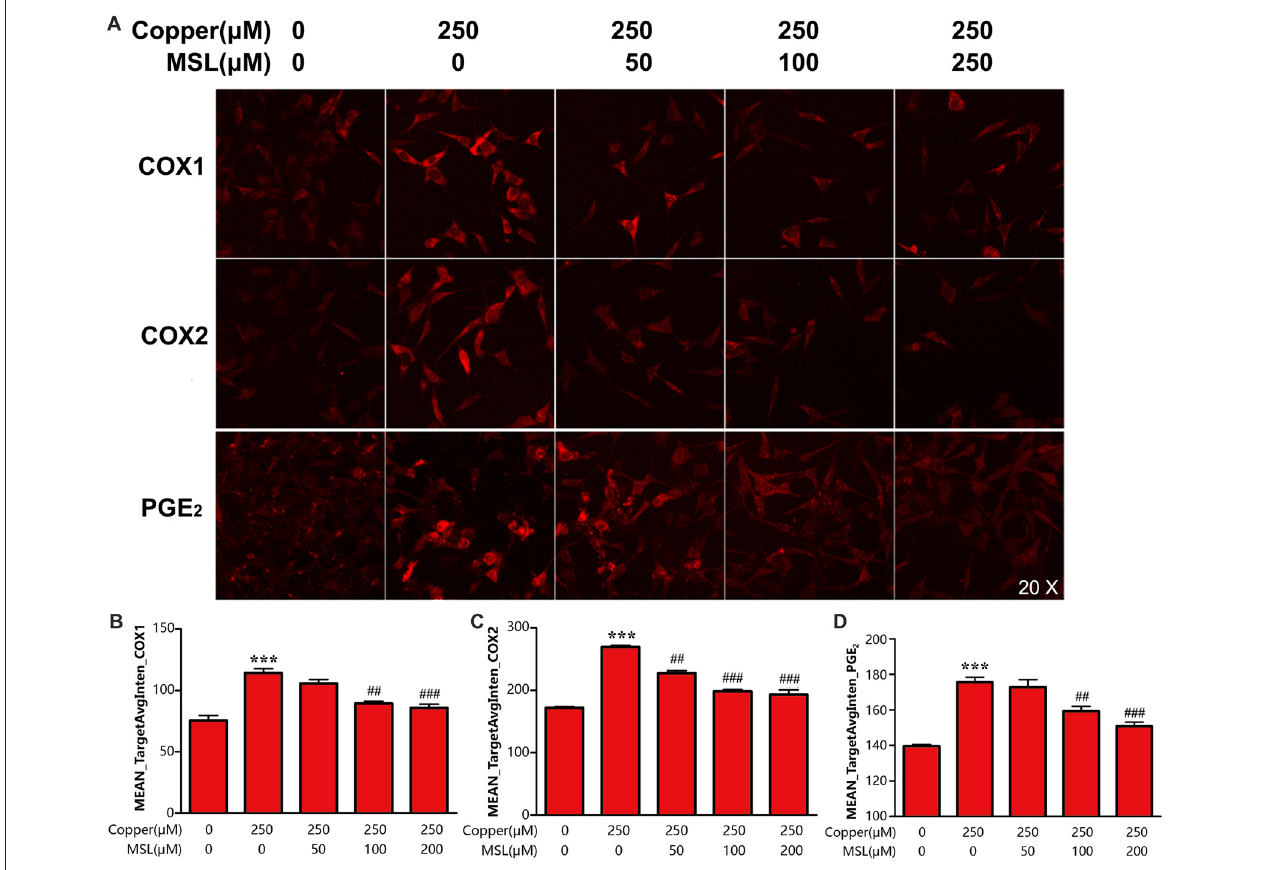
FIGURE 6 | MSL inhibited the expression of cyclooxygenase (COX) and prostaglandin E2 (PGE2) generation of APPsw cell in the presence of copper. (A) Immunofluorescence analysis was used to determine the expression of COX1/2 and the production of PGE 2 of APPsw cells in the presence of copper. Fluorescent images and intensities were analyzed by a Cellomics ArrayScan high-content screening (HCS) Reader and software. Quantified values of COX-1 (B) , COX-2 (C) and PGE 2 (D) were analyzed by Mean_Avginten. Data are expressed as the mean ± SEM, n = 6, ∗∗∗ p < 0.001 vs. untreated cells; ## p < 0.01, ### p < 0.001 vs. copper-treated